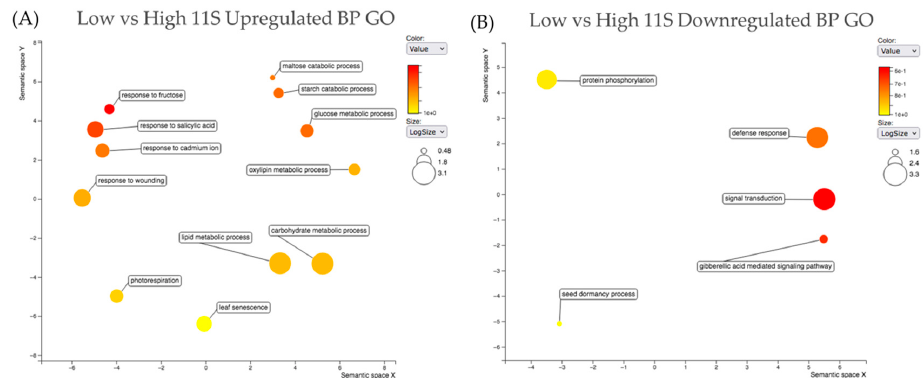
Figure 7. Revigo plots summarizing the relationships between the most indispensable BP GO terms for the upregulated ( A ) and downregulated ( B ) shortlist genes across the high vs. low 11S DE analyses. Circle size represents logSize value, higher logSize values indicate a strong presence of a term and/or its daughter terms; more general terms have larger bubbles. Color represents significance of a term among the query set of